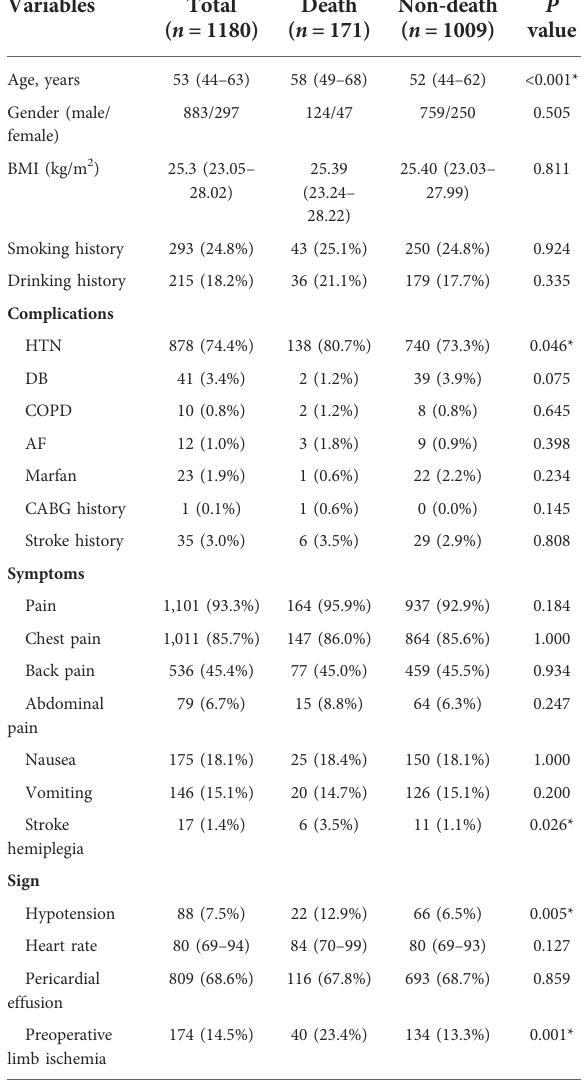
TABLE 1 Demographics and characteristics of non-death and death AAD